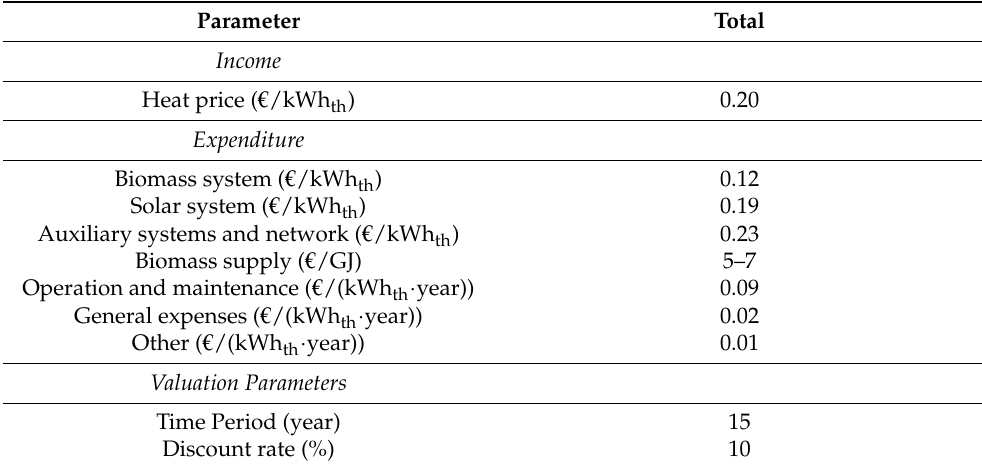
Table 4. Main parameters of the economic analysis for base scenarios as an approach. Parameter Total Income